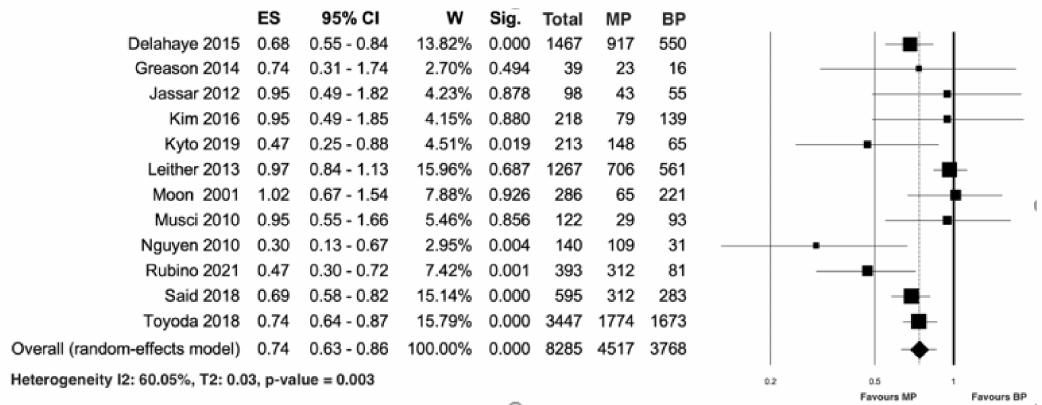
Figure 2. Forest plot for long-term survival. Abbreviations: ES, effect size, indicating the hazard ratio; CI, confidence interval; W, weight; MP, mechanical prosthesis; and BP, biological prosthesis.